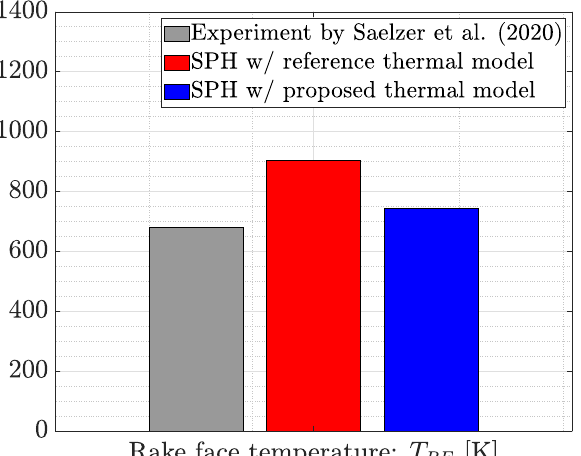
Figure 8. Distributions and contours of temperature obtained by SPH using the reference and proposed thermal model. An average of the rake face temperature in simulation results (considering the particles inside the black frames) is compared to the experimental measurement provided by [41]. The color bar is limited to 945 K for better